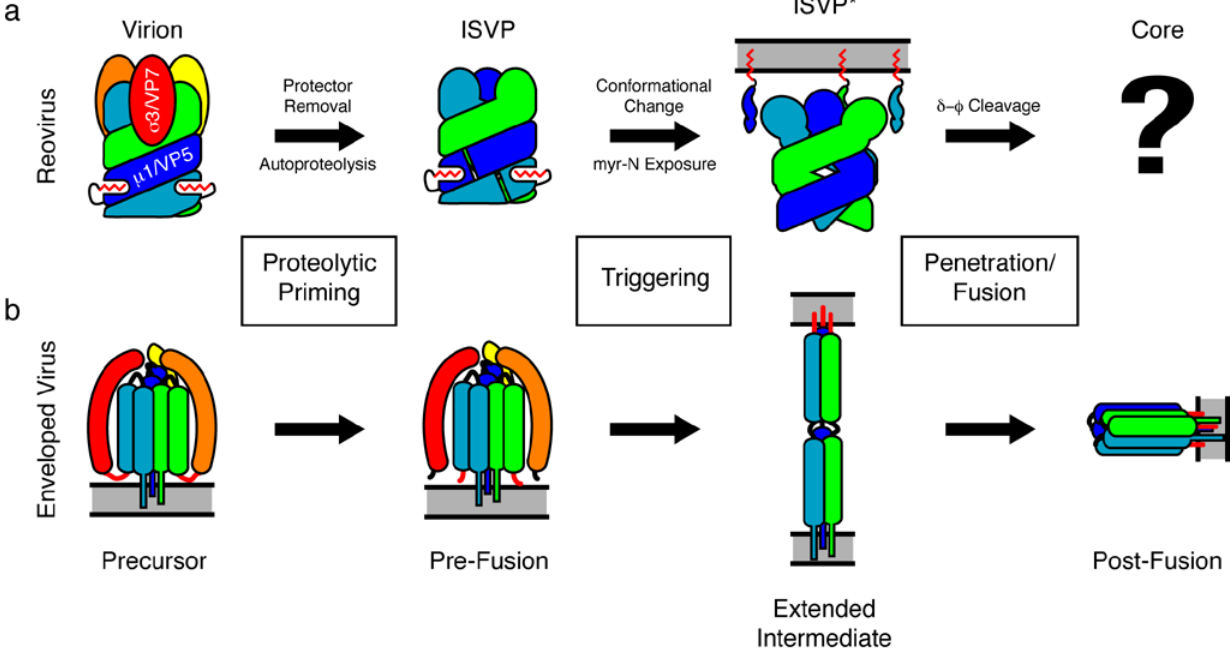
Figure 1. Comparison of the reovirus membrane penetration mechanism with the membrane fusion mechanism of enveloped viruses. (a) Cartoon of reovirus membrane penetration. The protection protein ( σ 3/VP7, warm colors) caps an intertwined trimer of the penetration protein ( µ 1/VP5, cool colors). The N-terminal myristoylation of the penetration protein is shown in red. The “?” indicates a gap in knowledge about the “post-penetration” conformations of the penetration protein fragments. (b) Cartoon of enveloped virus membrane fusion. The functional equivalents to the reovirus protection and penetration protein are colored similarly (e.g., influenza HA in cool colors), with the fusion peptide indicated in red. Image adapted in part from reference